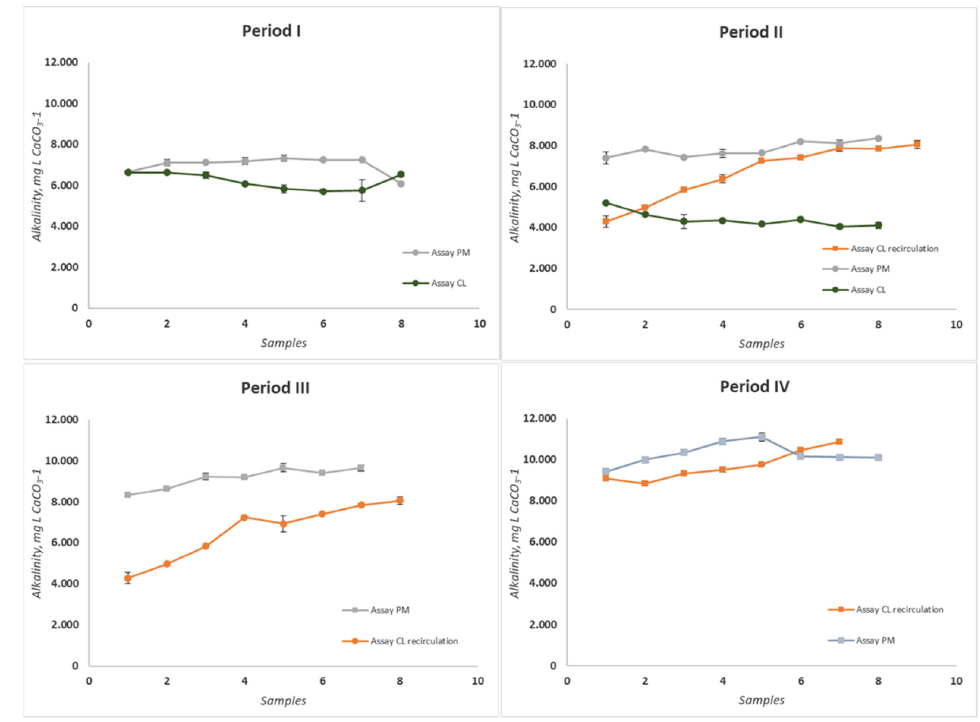
Figure 4. Alkalinity evolution for each studied period at different OLRs.